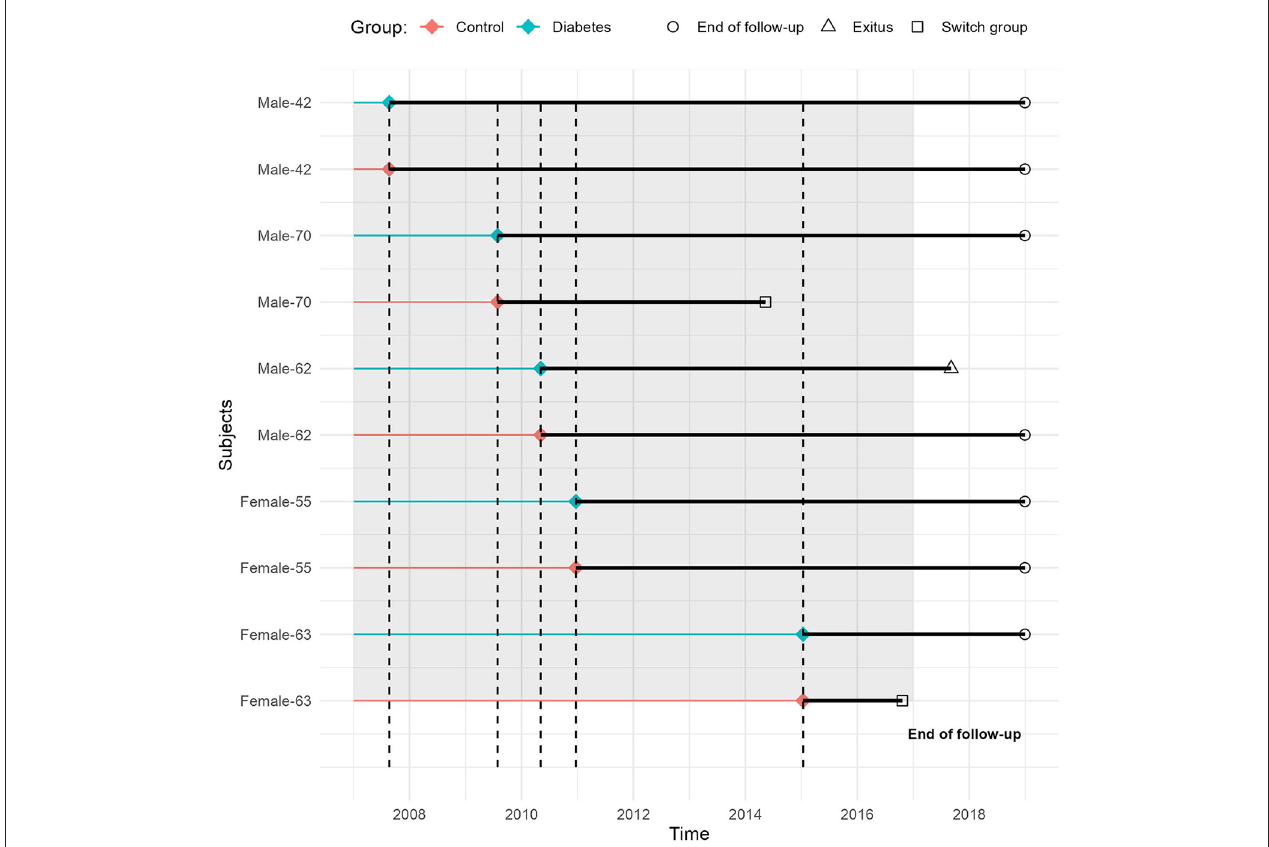
FIGURE 1 | Sampling and follow-up scheme: an example of s pairs of individuals by age and sex.